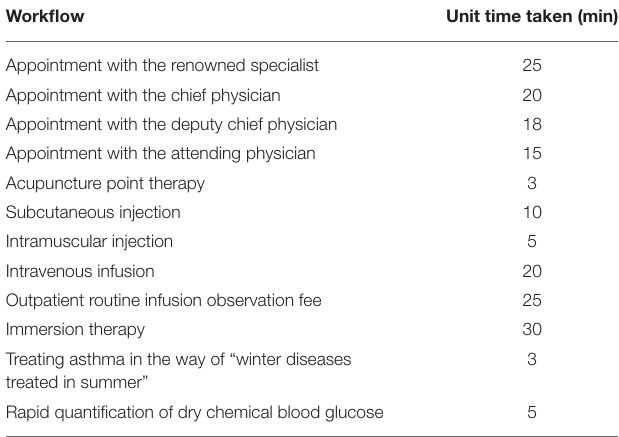
TABLE 1 | Time consumption of medical operation